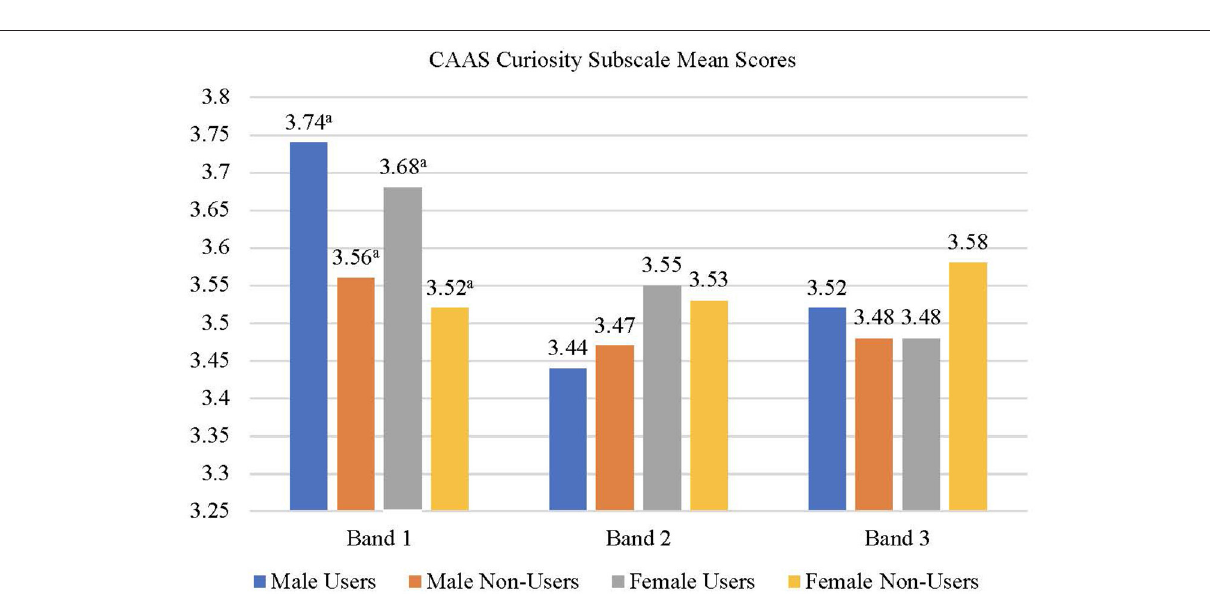
reported a higher degree of decision clarity than students who did not used the system [ F (1,2,918) = 9.39, p > 0.01, partial eta squared = 0.003]. Male students expressed greater decision clarity than female students [ F (1,2,918) = 11.43, p > 0.001, partial eta squared = 0.004]. There was also a